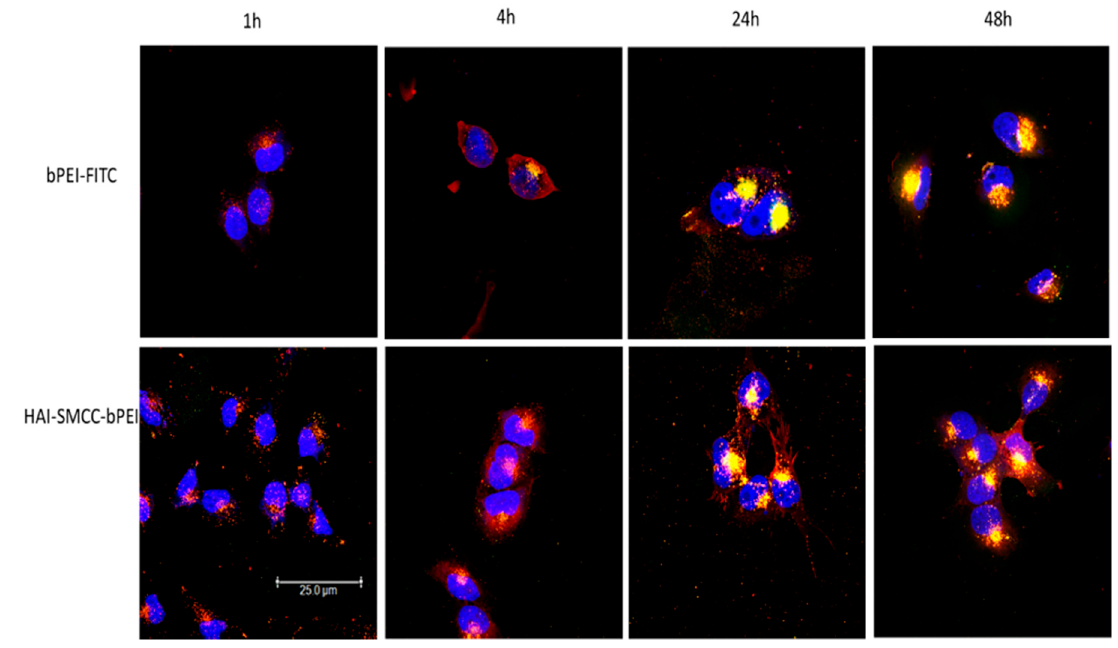
Figure 5. Subcellular distribution of bPEI and HAI-SMCC-bPEI polyplexes in H1299 was imaged by the confocal microscope. H1299 cells were transfected with bPEI and HAI-SMCC-bPEI polyplexes prepared with 50 pmol of siRNA fluorescently labeled with Ty563 at N/P = 5 for 1, 4, 24 and 48 h. The polymers were fluorescently labeled with FITC and shown in green. siRNA-Ty563 was shown in red, and DRAQ5 TM stained nuclei were shown in blue.